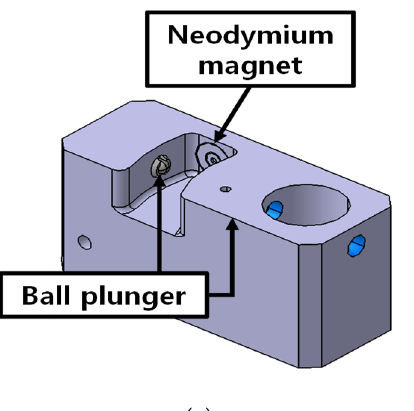
Table 5. Connection angle of truss-links.